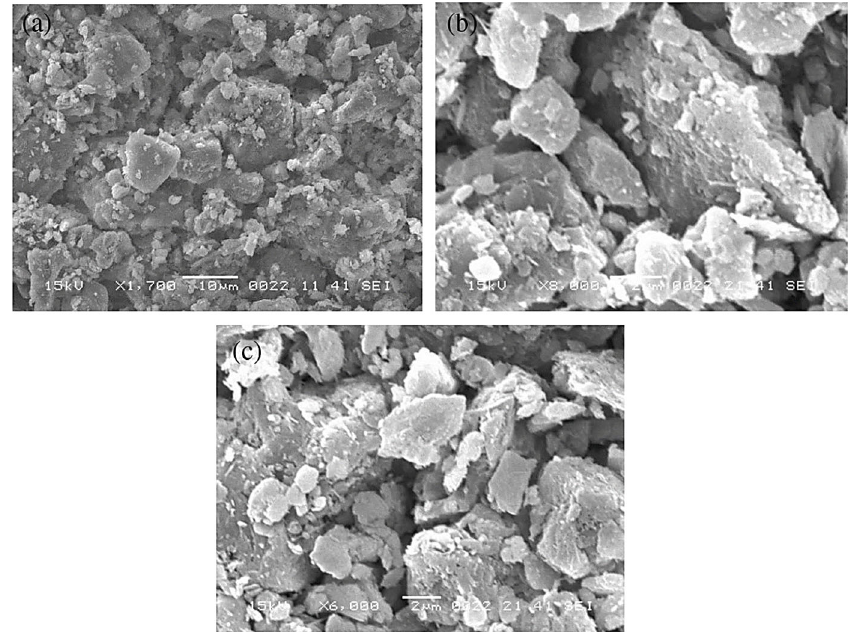
Figure 15. SEM images of dust samples: ( a ) dust sizes ( b ) Adhesion to large particles, and ( c ) Flake ‐ like particles. Reprinted from Solar Energy, 141, Mehmood U. et al., Characterization of dust col ‐ lected from PV modules in the area of Dhahran, Kingdom of Saudi Arabia, and its impact on pro ‐ tective transparent covers for photovoltaic applications, 205., Copyright (2017), with permission from Elsevier [66].